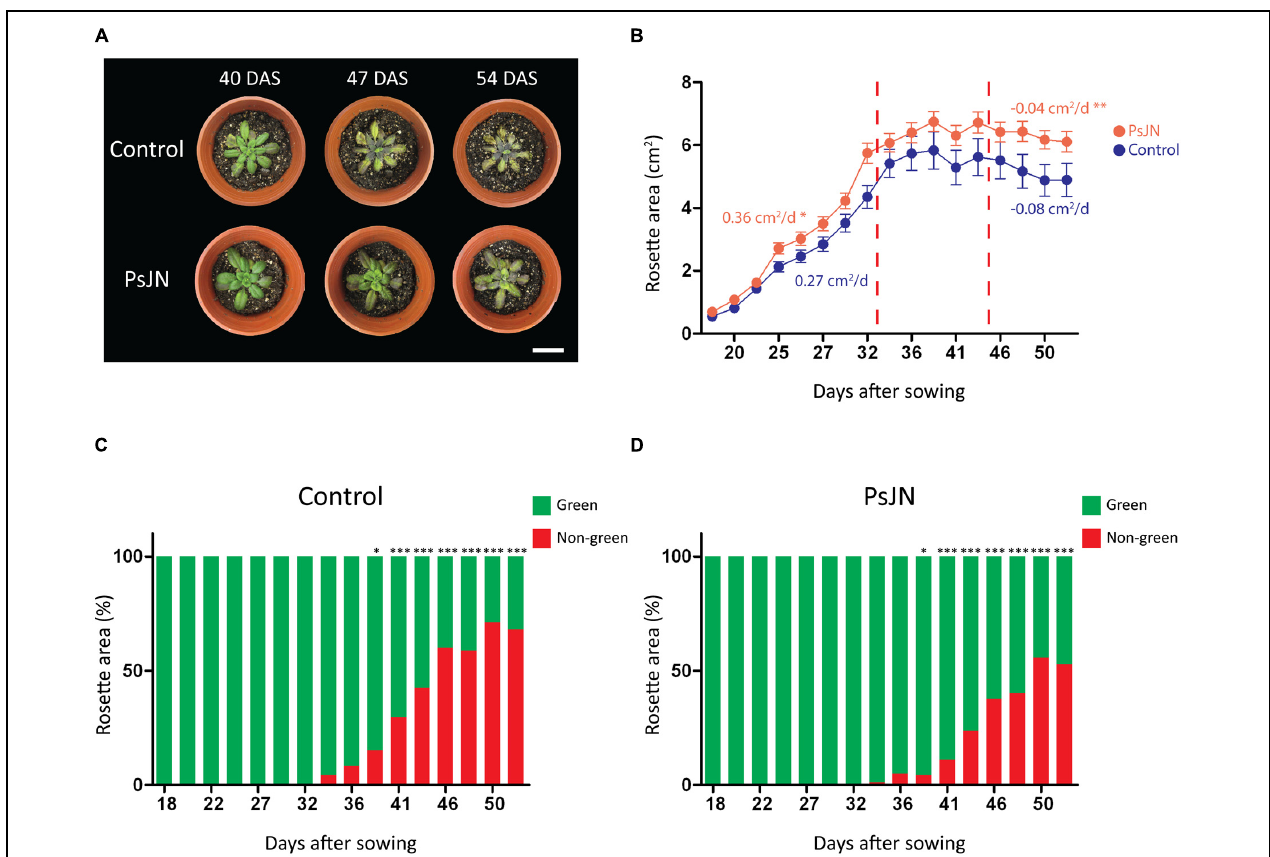
FIGURE 3 | Effects of B. phytofirmans PsJN on A. thaliana long-term growth in saline media. (A) Representative photographs of A. thaliana plants treated with or without B. phytofirmans PsJN, and transplanted at 11 DAS to individual pots with a 2:1 mix of peat/vermiculite and irrigated periodically with saline solution containing 150 mM NaCl/15 mM CaCl 2 . (B) Graphic representation of average rosette area (growth rate is indicated for the first and